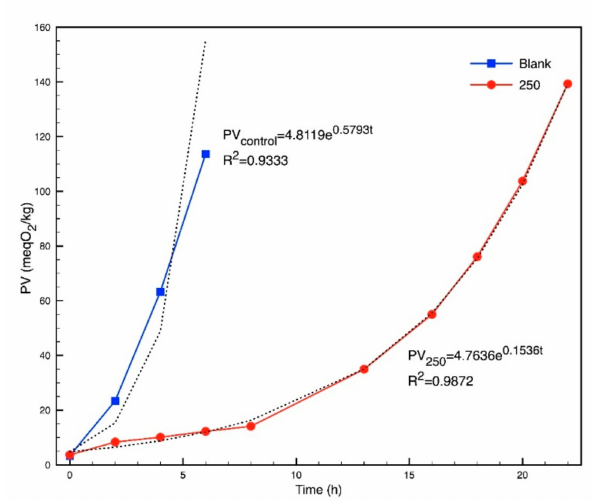
Figure 5. Peroxide value (PV) behavior in the active oxygen method (AOM) assay and exponential regression